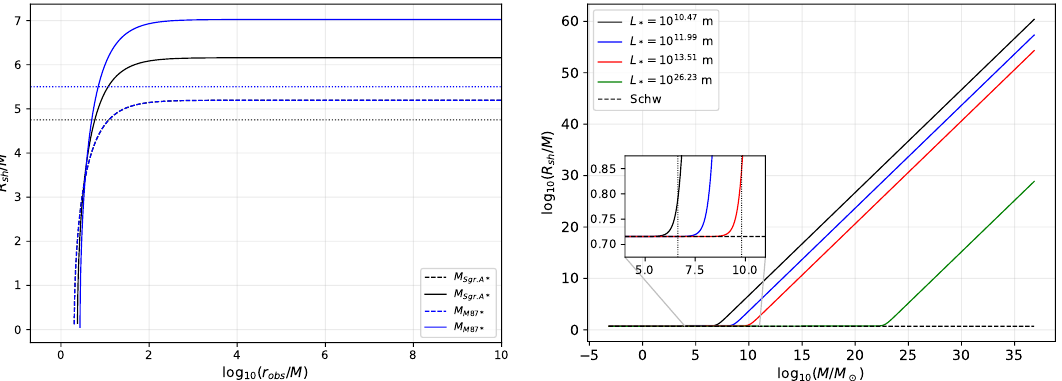
Figure 2. ( Left ): the shadow radius of Sgr. A* and M87* with observer location dependency. The dashed line represents the Schwarzschild case and the solid line for the general extended uncertainty principle (GEUP) case. The horizontal black and blue dotted lines represent the shadow radius of Sgr. A* and M87* based on the Event Horizon Telescope (EHT) data [1,2]. ( Right ): the shadow radius as a function of the black hole mass. The black and blue vertical lines in the inset plot represent the mass of the Sgr. A* and M87*, respectively. “Schw” denotes the Schwarzild case and M (cid:12) denotes the mass of the